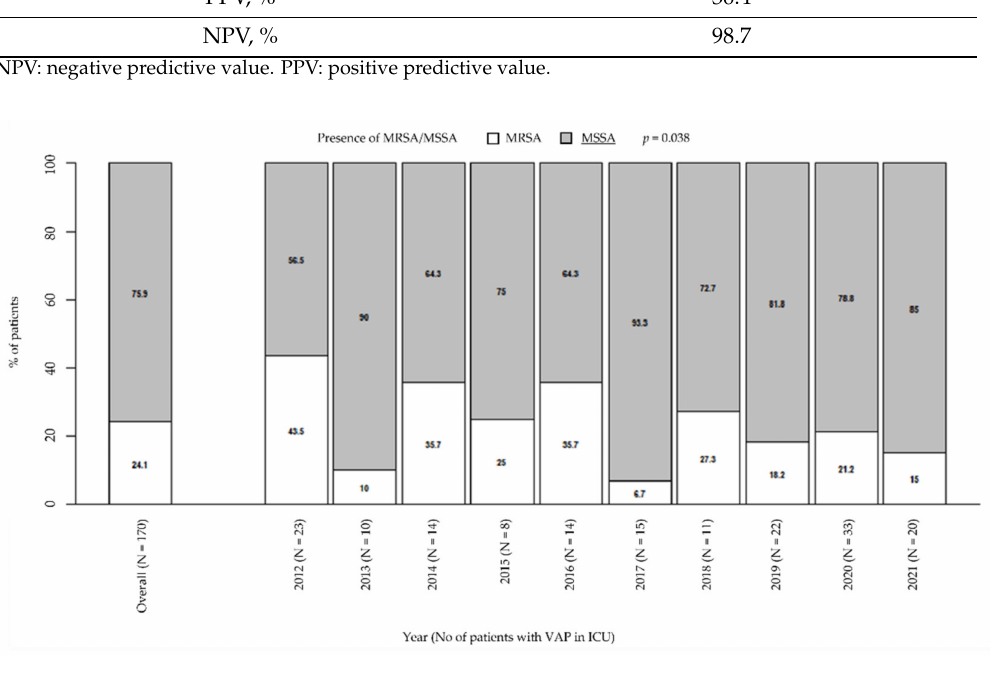
Figure 1. Prevalence of MRSA/MSSA in patients with VAP in ICU. p -value by Chi-squared test for trend in proportions. ICU: intensive care unit. MRSA/MSSA: methicillin-resistant Staphylococcus